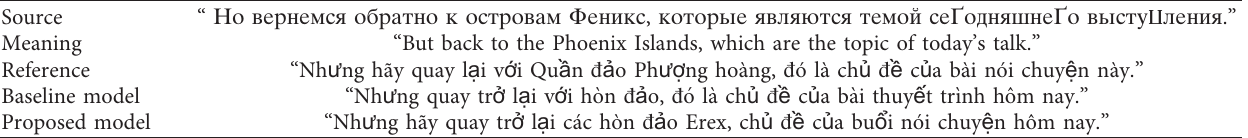
Table 7: Second case study with inaccurate translations. “But back to the Phoenix Islands, which are the topic of today’s talk.”